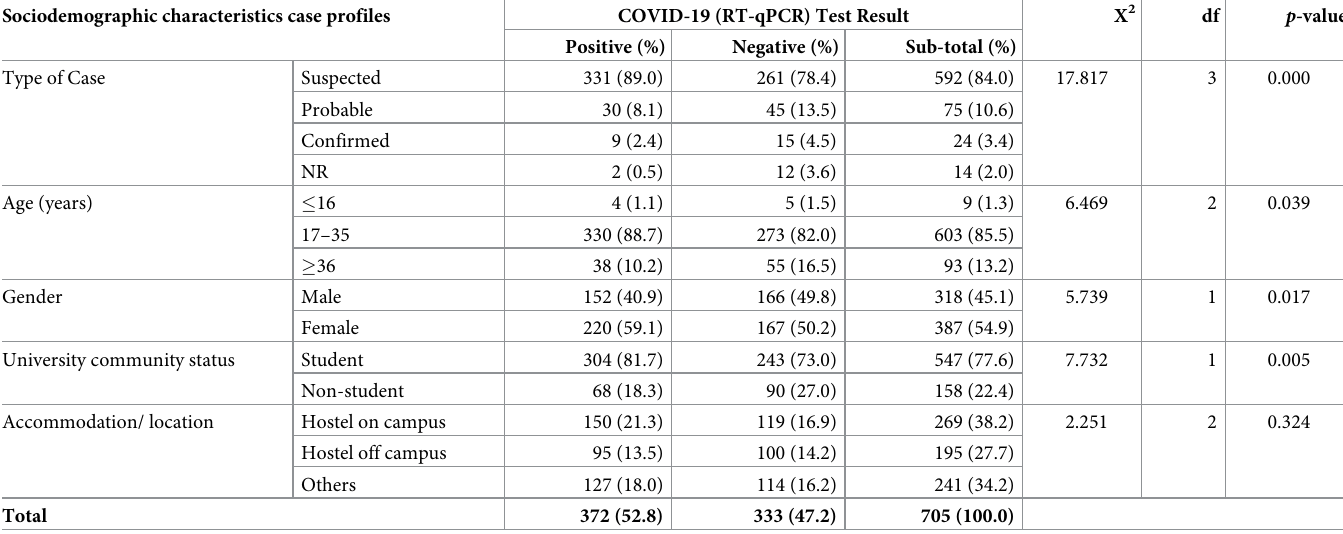
Table 1. Sociodemographic characteristics of study participants. Sociodemographic characteristics case